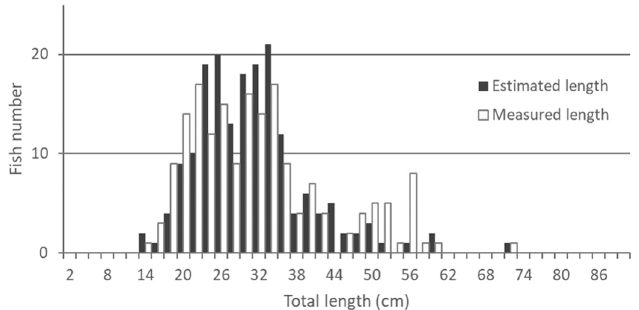
Fig. 5. Mean length distribution estimated by the Sonar5-Pro software and measured manually with SMC software for the 179 individual fi sh tracked by the Sonar5-Pro DIDSON